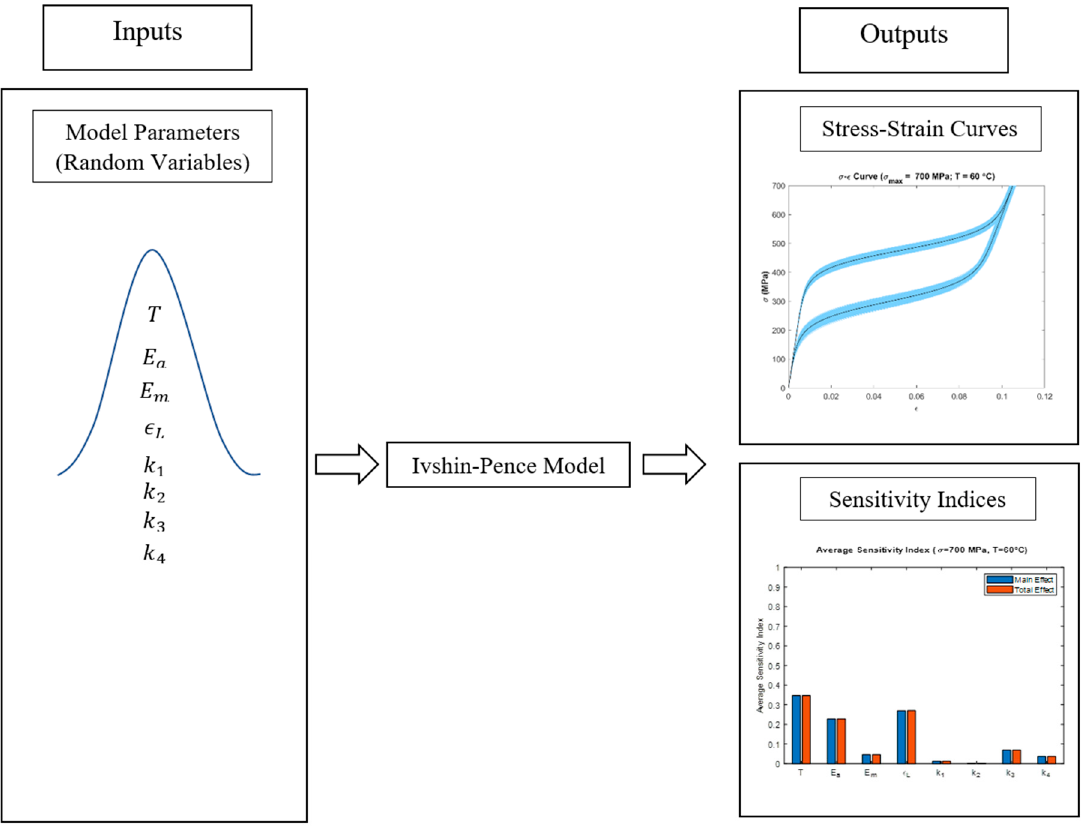
Figure 2. Uncertainty and sensitivity analysis outputs according to the eight input parameters.